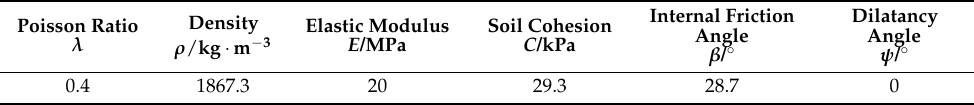
Table 2. Parameters of Mohr-Coulomb model of small soil deformation.